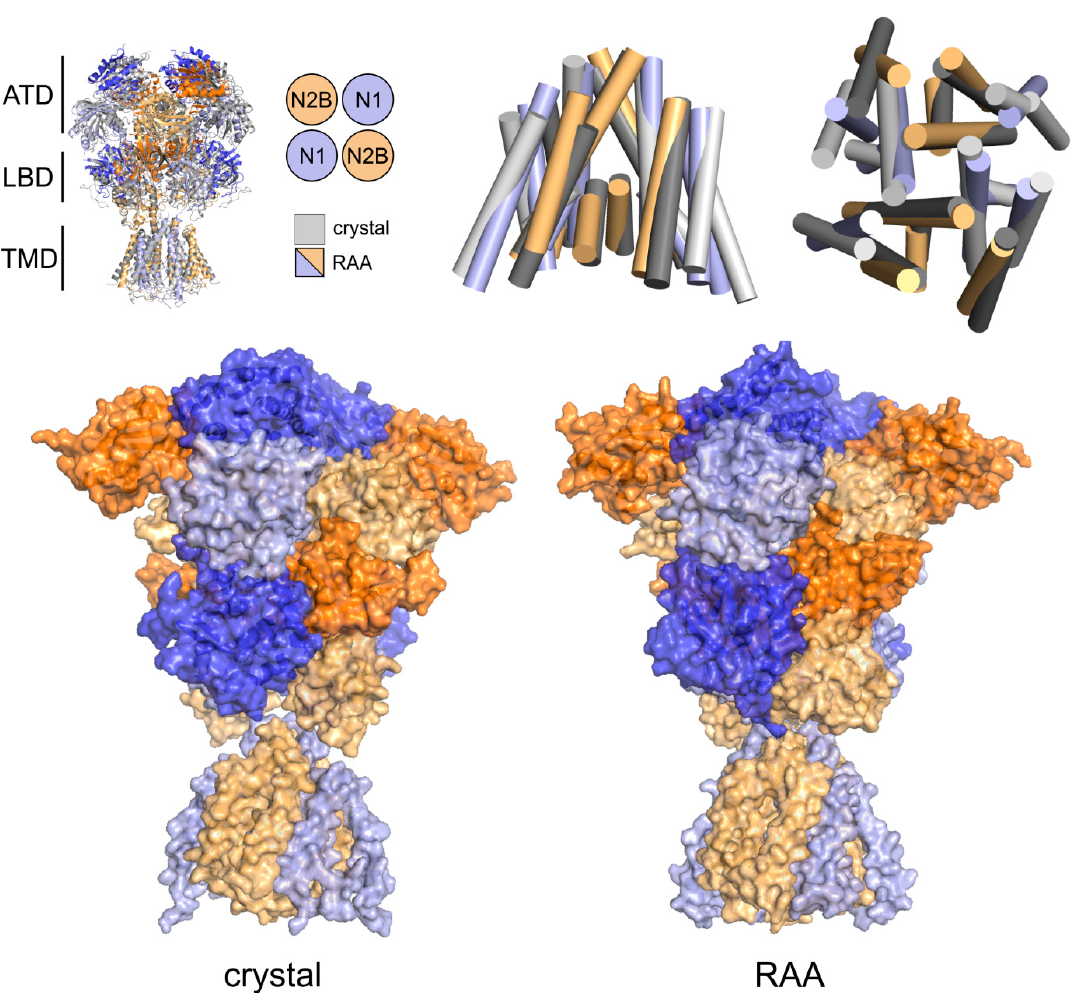
Figure 1. Relaxation of the crystal-based homology model. ( Top ) Summary of the N -methyl- d -aspartate (NMDA) receptor architecture showing structure superposition of NMDA receptors (NMDAR) models revealed relatively small differences between the starting crystal structure-based homology model (grey) and the relaxed receptor in the agonist activated receptor (RAA) state shown in blue/orange for GluN1/Glun2B subunits. Superposition of the transmembrane domain led to subtle rearrangement of the outer helices, while the arrangement of central M3 helices was not changed. ( Bottom ) During the relaxation simulation we observed changes in the amino-terminal domain (ATD) and ligand-binding domain (LBD) region, probably as a consequence of the sequence differences between the original crystal structure and the homology model. Overall the receptor kept the crystal structure arrangement and the changes were limited to a slight lifting of the GluN2B NTD domain and rotation around the longitudinal axis of the receptor. The rather flexible linkers connecting the TMD and LBD are not displayed for clarity.